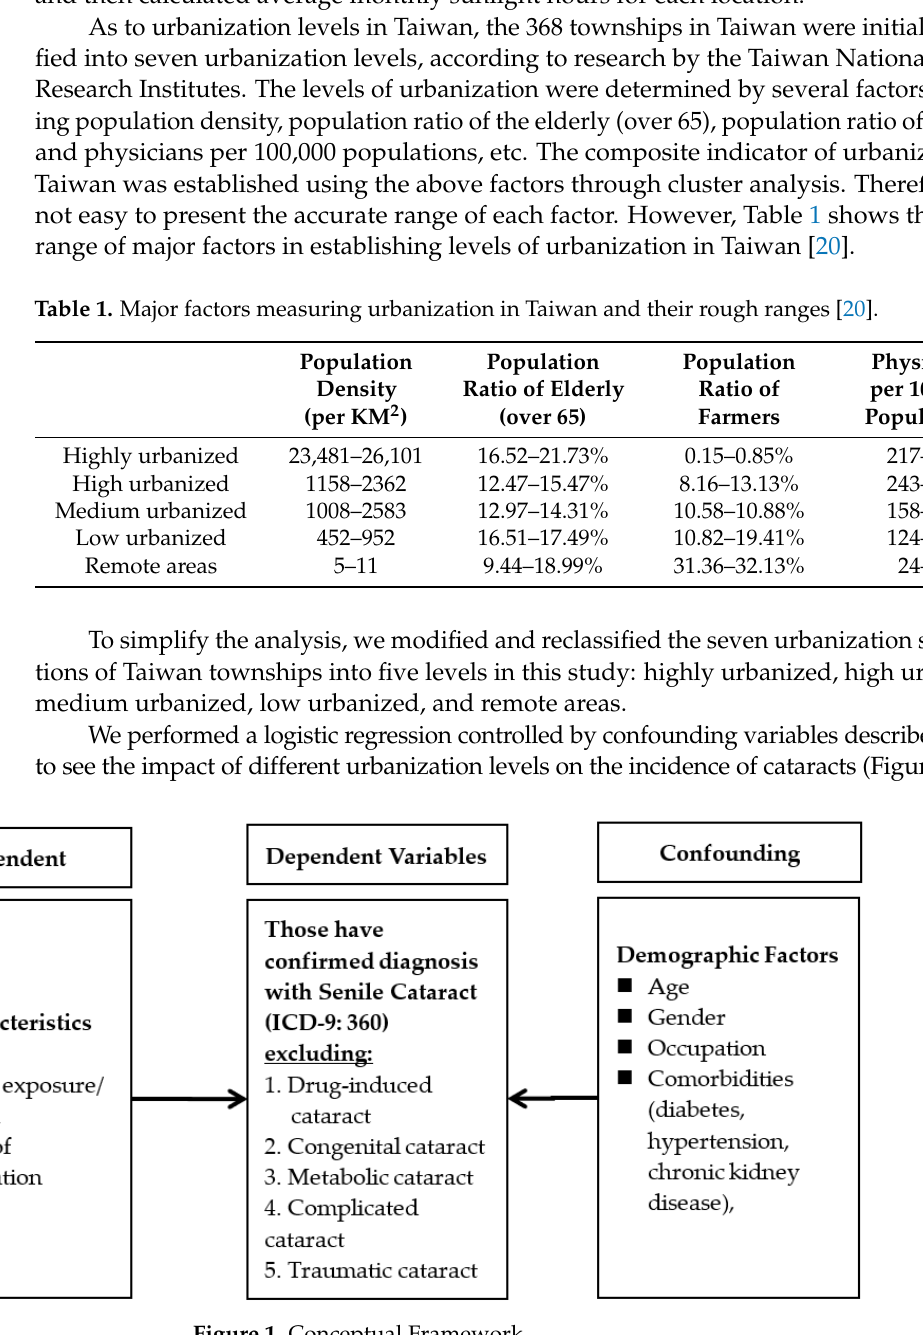
Figure 1. Conceptual Framework.